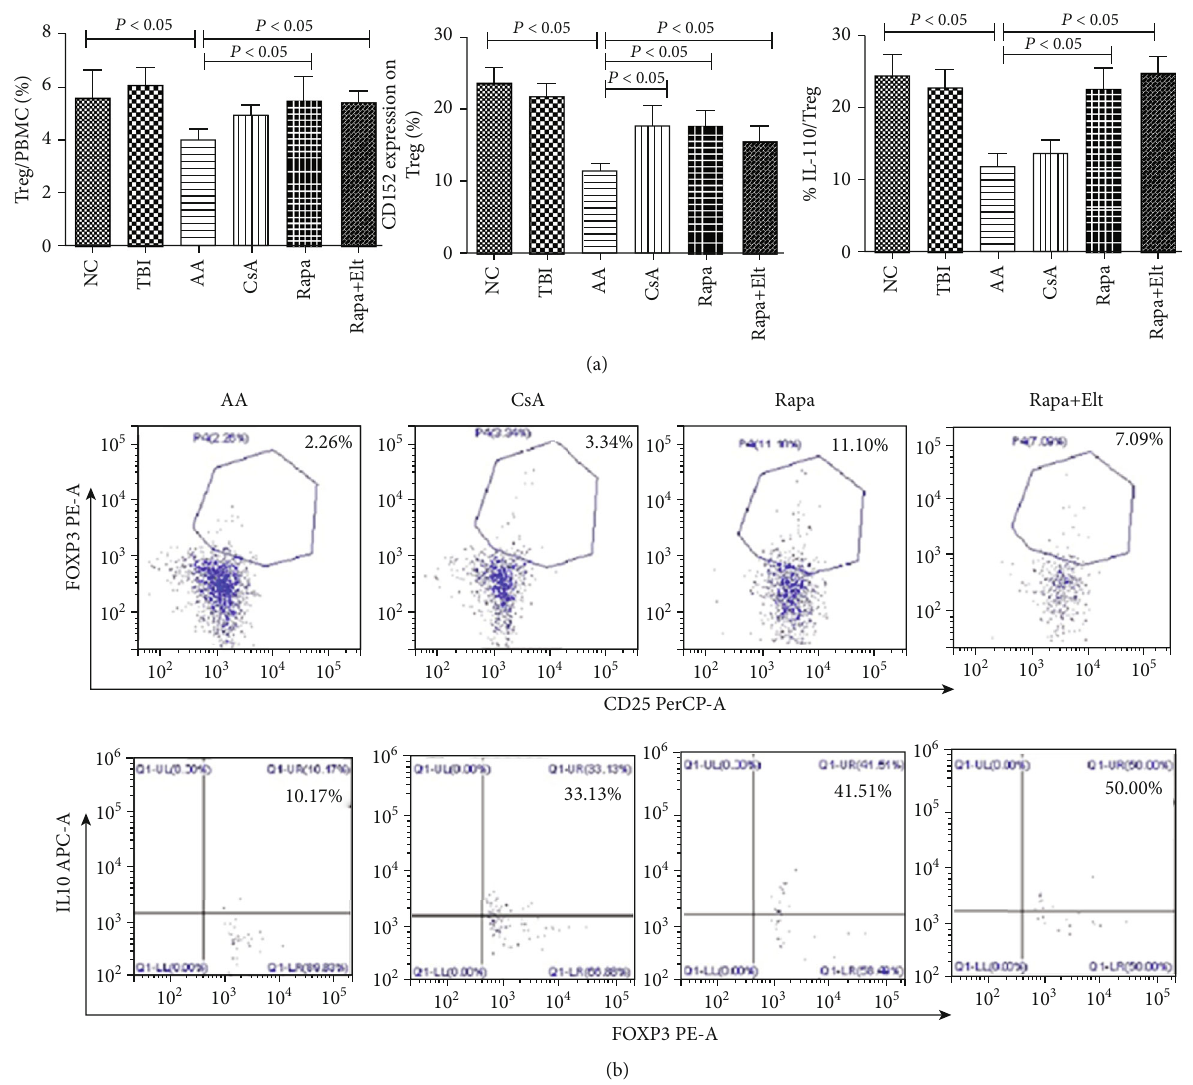
Figure 7: E ffi cacy of rapamycin combined with eltrombopag on regulatory T cells. (a) The ratio of regulatory T cells increased notably in the AA group after receiving CsA, Rapa, or Rapa+Elt, respectively, and there was a signi fi cant di ff erence between the Rapa group and AA group, as well as the Rapa+Elt group and AA group ( P < 0 : 05 ). There was no signi fi cant di ff erence between the e ff ect on numbers of Tregs of the Rapa and Rapa+Elt groups. No signi fi cant upregulation of the CD152 expression was observed on Tregs in the AA group after receiving Rapa or Rapa+Elt, respectively. As for IL-10, Rapa can increase the secretion of IL-10 from Treg cells compared with the CsA group and had a better outcome when combined with Elt in AA mice. (b) Representative fl ow cytometry analyses of the secretion IL-10 in Tregs and Tregs/PBMNC ratio after Rapa alone and combined with Elt